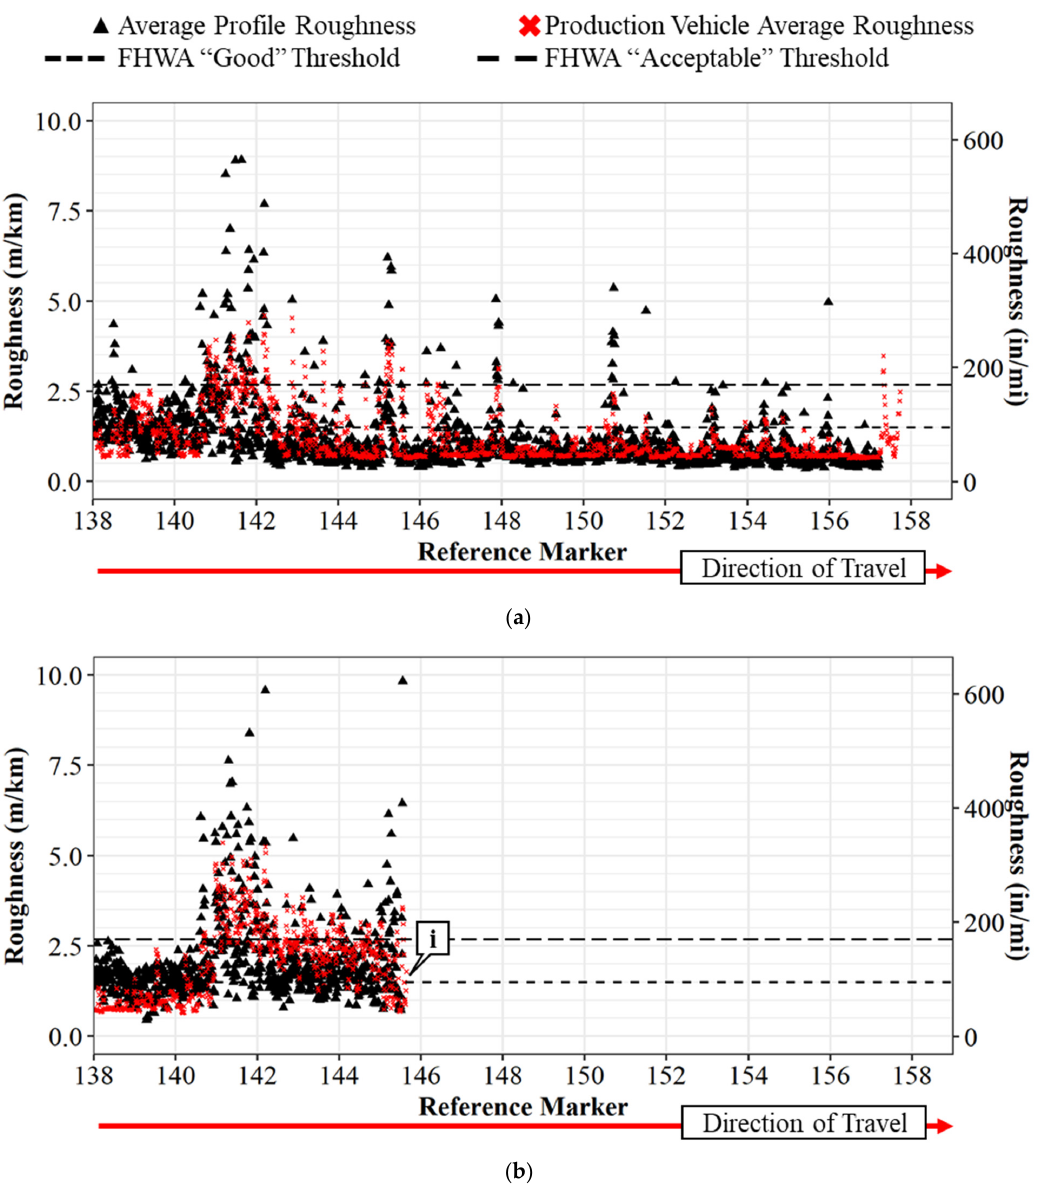
Figure 5. IRI comparison between inertial profiler and single production vehicle for I-65 northbound: ( a ) left lane; ( b ) right lane. Callout (i) data collection discontinued due to congestion.